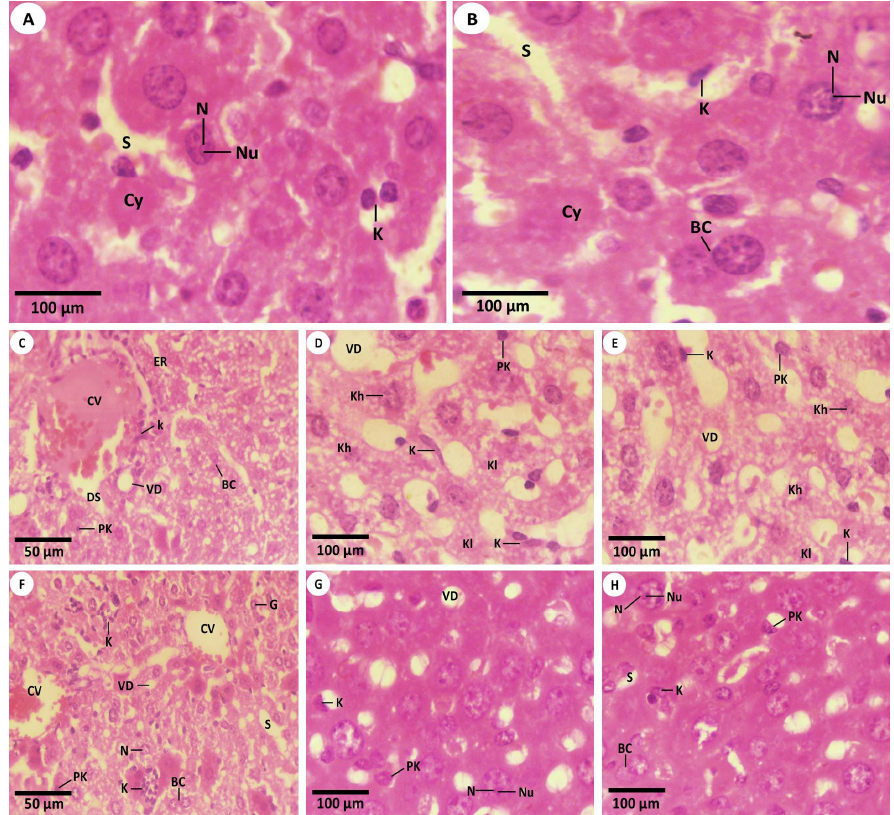
Figure 3. Light histopathological investigation in the liver tissues of control mice (first group), PPE- treated mice (second group), mice exposed to Fe 2 O 3 -NPs (third group), and Fe 2 O 3 -NPs plus PPE- treated mice (fourth group) ( A ) Mouse liver section from the first group displays the healthy tissue that shows the normal structure of liver cells with a normal nucleus (N) and nucleolus (Nu), clear cytoplasm (Cy), Kupffer immune cells (K), and normal blood hepato-sinusoids (S) (Hx.E., 1000×). ( B ) Mouse liver from the second group that displays the normal structure of the clear cytoplasm (Cy) of hepatocytes, Kupffer cells (K), binucleated cells (BC), intact hepatocytes with normal nuclei (N) and a normal nucleolus (Nu), and normal blood hepato-sinusoids (S) gaps (Hx.E., 1000×). ( C ) Mouse liver section from the third group that revealed coagulated hepatocytes with necrosis that appeared densely eosinophilic with the pyknosis stage (PK), endothelial erosion (ER) located in the boundary of the central vein, vacuolar degeneration (VD), the dilation of the blood liver sinusoids (DS), the distortion of the central vein (CV), Kupffer cells (K), and binucleated (BC) (Hx. E., 400×). ( D ) Magnified field of the mouse hepatic slide that appeared in the third group that shows obvious vacuolar degeneration (VD), pyknotic cells in the necrosis stage (Pk), karyorrhexis (Kh), karyolysis (Kl) hepatocytes, and many Kupffer immune swollen cells (K) (Hx. E., 1000×). ( E ) Another magnified field from the mouse hepatic section in the third group that displays the coagulated necrosis of hepatocytes, densely esinophilic nuclei with pyknosis (PK), karyorrhexis (Kh), karyolysis (Kl) of hepatocytes, many Kupffer immune cells (K), and vacuolar degeneration (VD) (Hx. E., 1000×). ( F ) Mouse liver section from the fourth group that displays the restoration of normal hepatic cords with mildly degenerated hepatocytes around the central vein (CV), a vacuolated cytoplasm, the widen- ing of hepatic blood sinusoids (S), intact single nuclei (N) or binuclei (BC), reduced pyknotic cells (Pk), vacuolar degeneration (VD), a hepatic giant cell (G), and Kupffer immune cells (K) (H. E., 400×). ( G ) Magnified field from the mouse hepatic section of the fourth group that shows a recovery in some hepatic strands, mild restoration hepatocytes with nuclei (N) and the nucleolus (Nu), pyknotic cells (Pk) that are decreased significantly, mild vacuolar degeneration (VD), and Kupffer cells (K) (Hx. E., 1000×). ( H ) Another magnified field from the mouse hepatic section that was obtained from the fourth group that displays a restoration of hepatic cords with the mild recovery of hepatocytes with nuclei (N) and the nucleolus (Nu), the reduction of pyknotic hepatocytes (Pk), the mild wid- ening of hepatic blood sinusoids (S), Kupffer cells (K), and binucleated (BC) (Hx. E., 1000×).